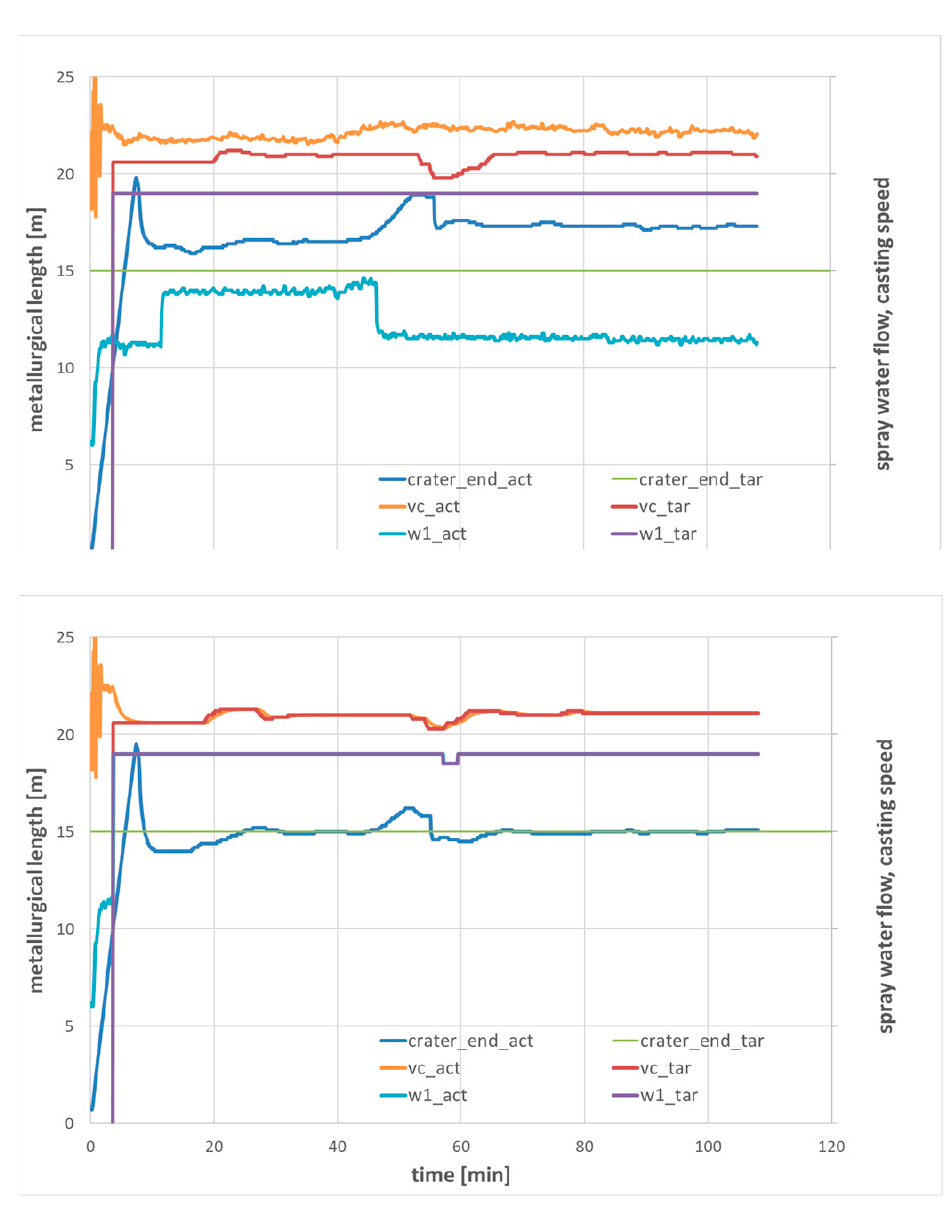
Figure 19. Evolution of actual and target casting speed, spray water flow and crater end position without ( top ) and with ( bottom ) application of target casting parameters for target crater end of 15 m at ESF billet caster.